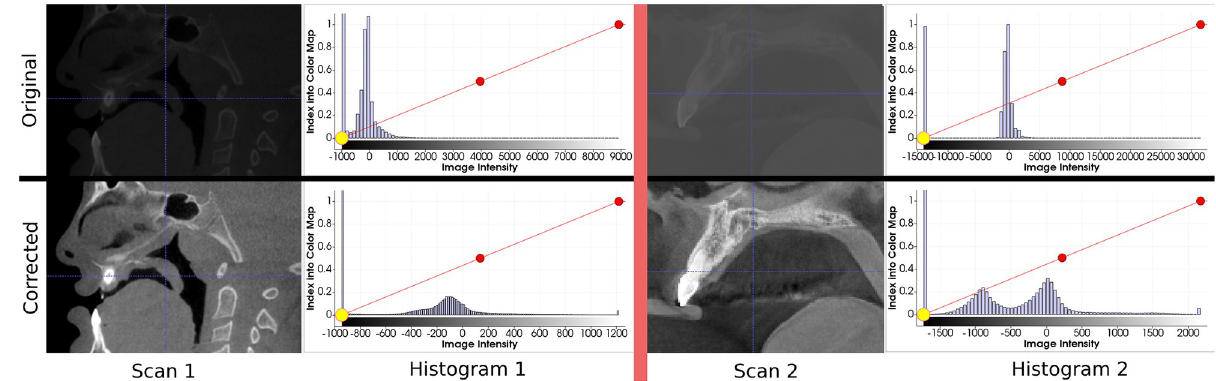
Fig 2. Visualization of the contrast adjustment steps on two different scans. This result is obtained by keeping the data between X min = 1% and X max = 99% on the cumulative graph.